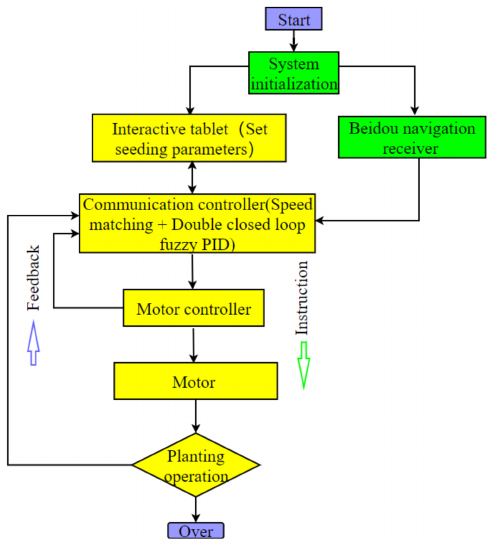
Figure 3. Schematic of the EDS control